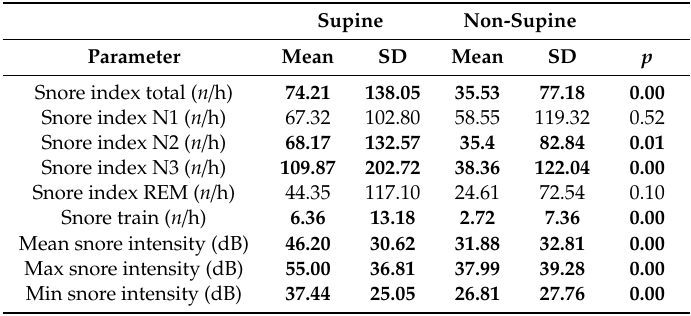
Table 7. Impact of the body position on snore indices.